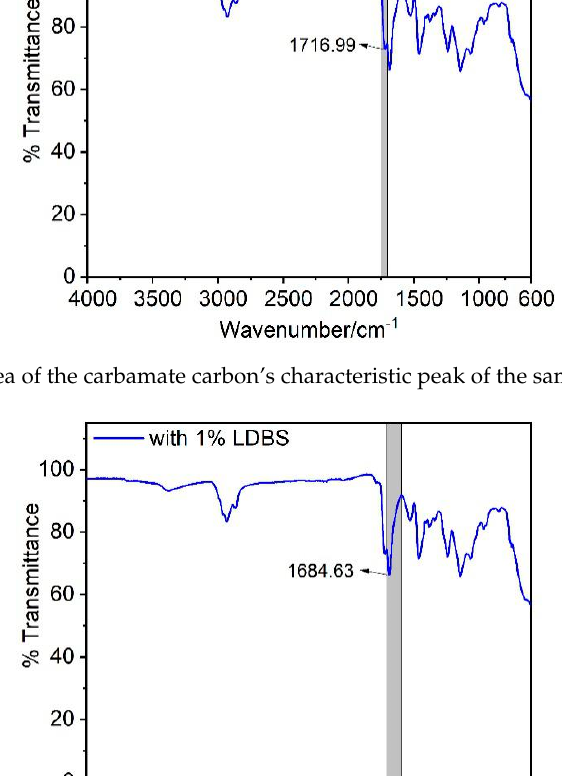
Figure 9. Integral area of the urea carbon’s characteristic peak of the sample with 1.0% LDBS.